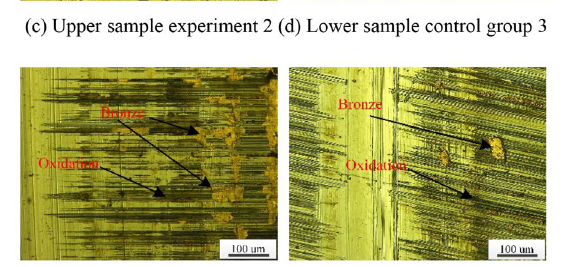
Figure 18 Surface morphology of the samples with 38CrMoAl lower sample Figure 19 Surface morphology of the test samples with 42CrMo